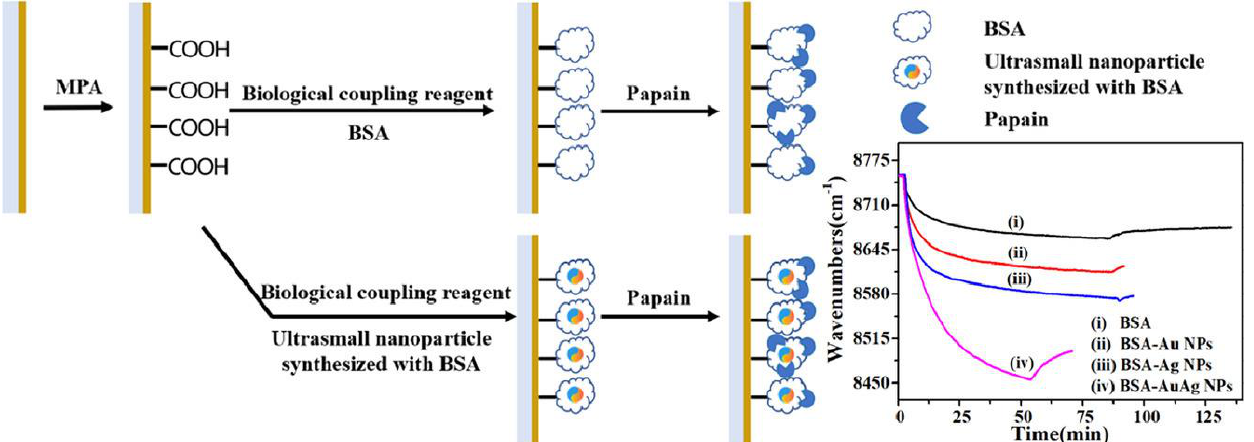
Figure 5. Schematic representation of the modified chip using BSA coated with ultrasmall u/AgNPs (1 − 3 nm) . BSA and BSA-Au/AgNPs bioconjugate were immobilized onto a 3-mercaptopropionic acid (MPA) SAM and allowed to interact further with papain. The binding of papain to the surface- immobilized BSA-Au/AgNPs provided the highest wavenumber shift. Reproduced from [78] with permission of